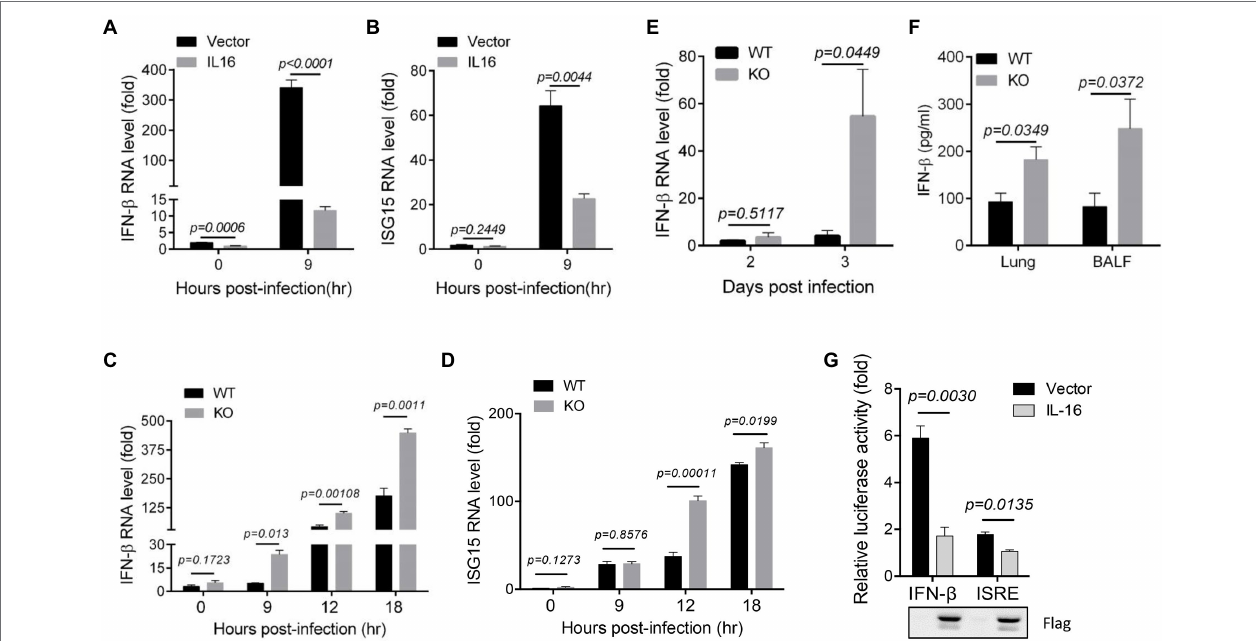
FIGURE 5 | IL16 inhibits interferon (IFN)- β and IFN-stimulated genes (ISG) expression. (A,B) A549 cells were transfected with vector or IL16-expressing plasmid for 24 h, followed by infection with PR8 virus (MOI = 5) for the indicated time points. The infected cells were harvested and subjected to qRT-PCR analyses with the specific primers corresponding to IFN- β (A) and ISG15 (B) . (C,D) WT and IL16 KO MEFs were infected with PR8 virus (MOI = 0.1) for the indicated time points, followed by qRT-PCR analyses with the primers corresponding to IFN- β (C) and ISG15 (D) . (E,F) C57BL/6 WT or IL16 KO mice (6–8 weeks) were infected with mock ( n = 6) or PR8 virus (10,000 PFU/mouse, n = 10). Lungs were harvested on day 2 and day 3 post-infection and detected for IFN- β through qRT-PCR analyses (E) , ELISA assay for IFN- β in the lung homogenates and BALF on day 3 post-infection (F) . (G) A549 cells were transfected with IFN- β or ISRE luciferase reporter